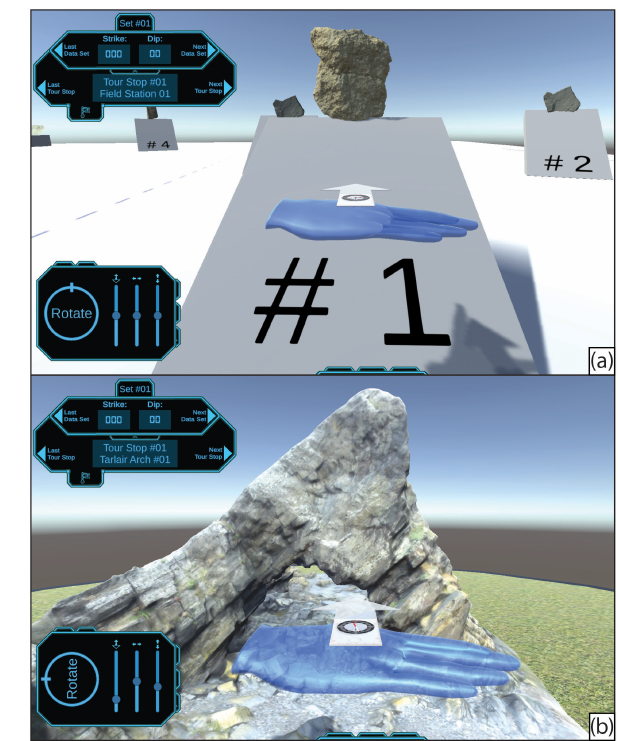
Figure 3. The two main settings: cubes and rocks . Each may be used with the bumper prefix to allow the user an error-flagging buffer when measuring platform/outcrop orientation ( ± 10 ◦ for strike and 5 ◦ for dip). Panel (a) shows the level cubes , which repli- cates the classroom beginner technique of using a platform to prac- tice taking strike and dip measurements. Panel (b) provides an ex- ample of the rocks level, which features 3D